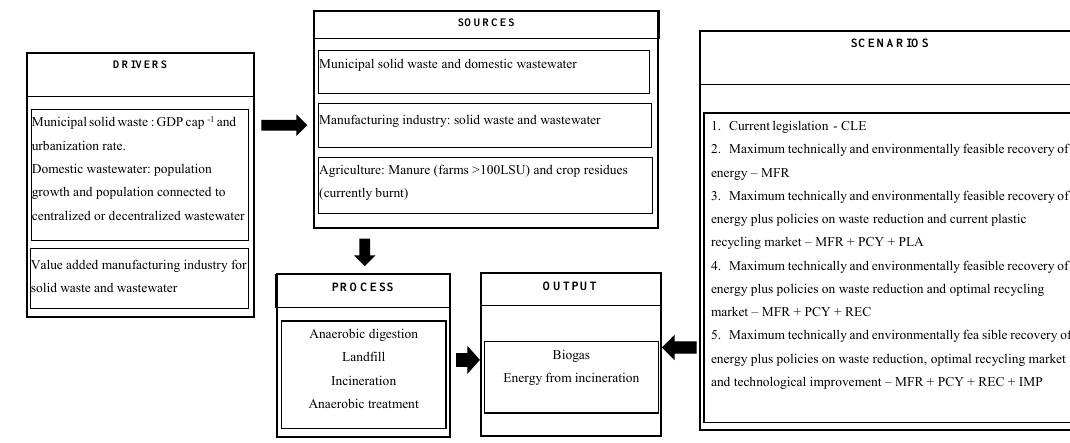
Figure 1. Research framework approach (GDP: Gross Domestic Product, LSU: Livestock